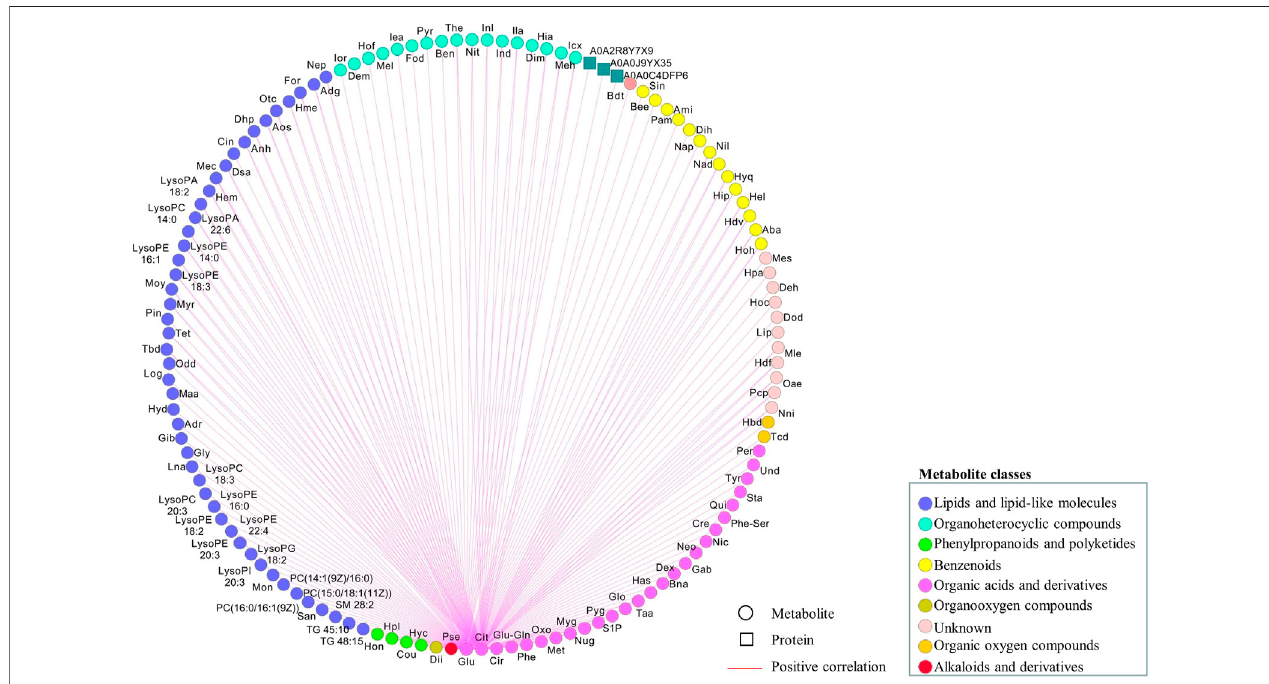
FIGURE5| Regulatory networkassociatedwithcitric acidorglutamine basedonsigni fi cantcorrelations ( r 2 ≥ 0.49and FDR ≤ 0.05).Metabolitesand proteins were respectively represented as circular and rectangle, and their relations as edges. Metabolites categorized into different pathways were displayed in different node colors. The positive correlations were shown in red. Computations of the correlations were performed under the R environment. Cytoscapewas employed to generate the graphical output of the networks.